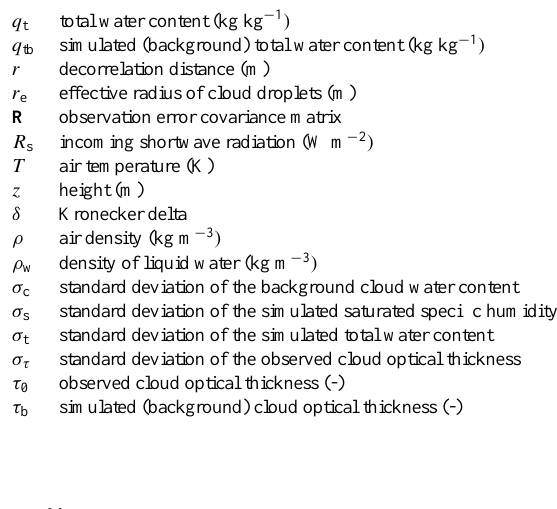
Figure 9: Left: Radio-sounding profile of temperature (red) and dew point temperature (blue) 3 Fig. B1. Left: radio-sounding profile of temperature (red) and dew point temperature (blue) at Trappes on 20 June at 12:00LT. Right: at Trappes on 20 June at 1200 LT. Right: Resulting cloud water profiles from experiments 4 resulting cloud water profiles from experiments with a non-diagonal B with a non-diagonal B matrix. 5